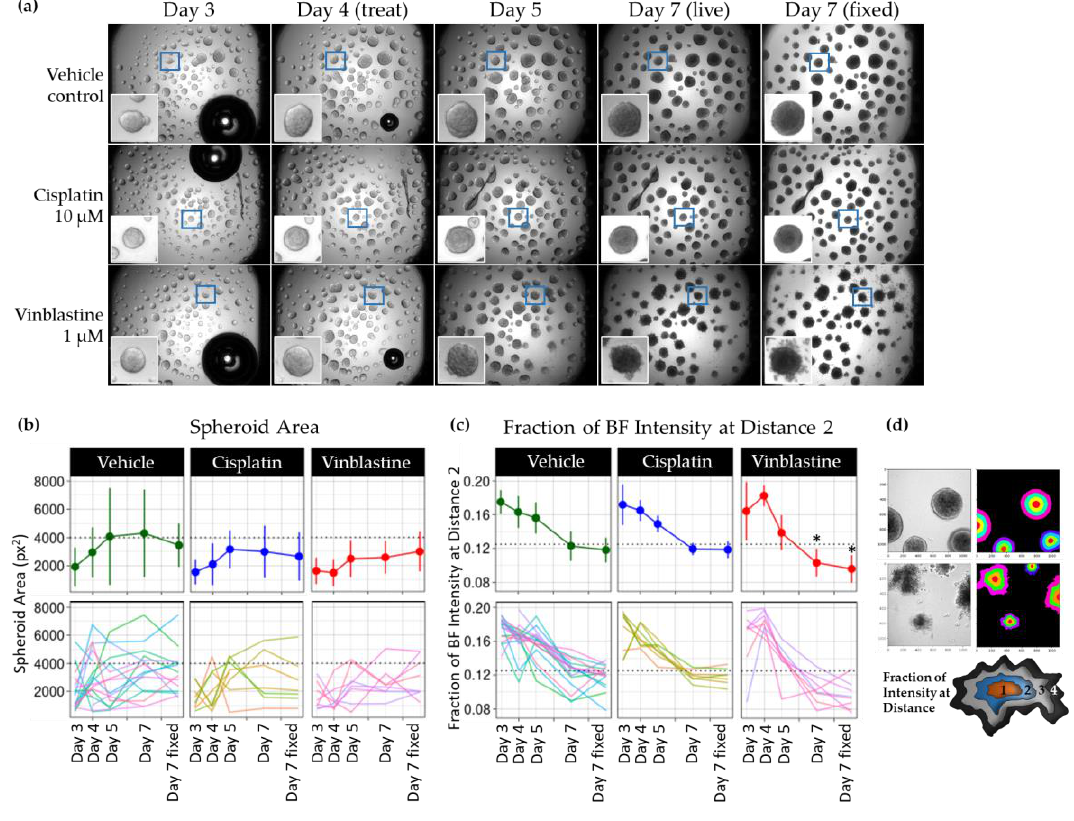
Figure 3. ( a ) Time course of brightfield images across live and fixed cells (2.5 × , Cytation 5). Individual organoid (blue square) is shown in higher magnification over time. ( b ) Area plotted as average (circles) and standard deviation (error bars) of at least 7 individual spheroids (top panel) and as single object traces (bottom panel). Reduced area growth in spheroids treated with cisplatin (10 µ M) and vinblastine (1 µ M) compared to vehicle controls (0.2% DMSO). ( c ) Vinblastine (1 µ M) signifi- cantly decreases the Fraction of brightfield (BF) intensity at Distance 2 compared to vehicle control at the same time point, corresponding to a darkening of the spheroid center at day 7. (* p < 0.03, ANOVA, Šídák’ s multiple comparisons test) ( d ) Visual representation of Radial Distribution (Inten- sity Fraction at four Distances, labelled 1, 2, 3, 4 radiating from the center) in vehicle controls (top) and vinblastine (5 µM) treated wells (bottom), a frequently used spheroid shape descriptor.